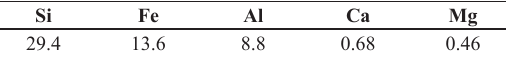
Table 2. Elements in ashes (wt.%). Results obtained by gravimetry and atomic absorption